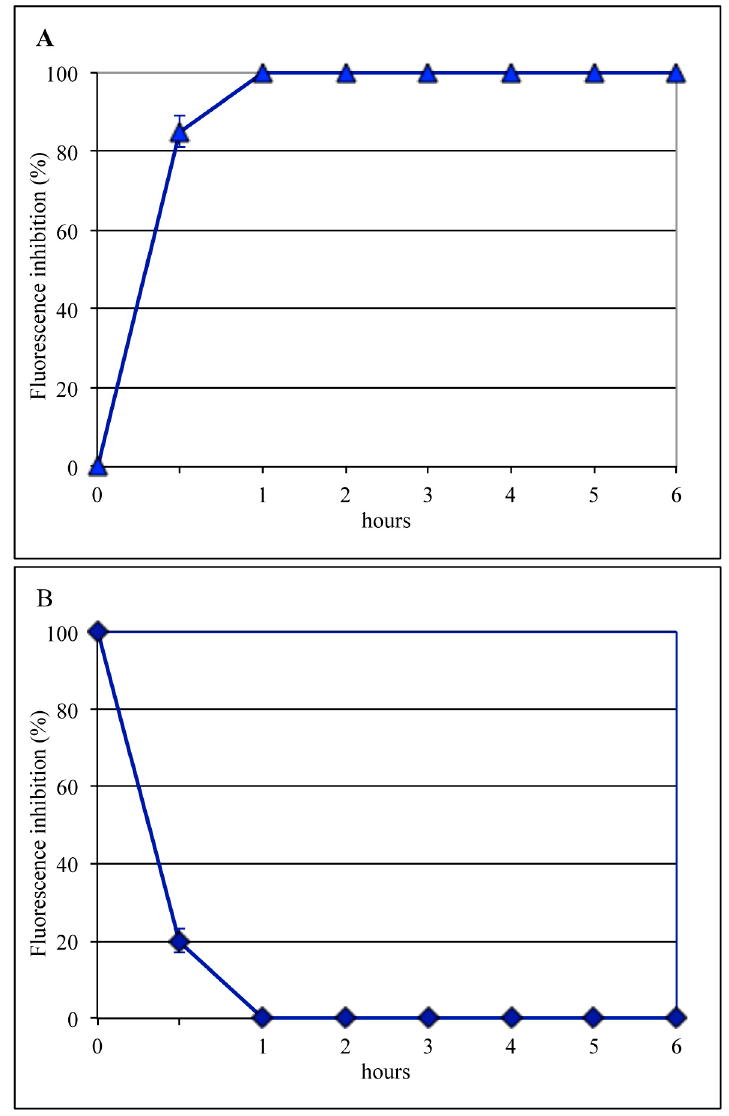
Figure 3. Addition-time effect of 20 mM NH 4 Cl on influenza virus infection. ( A ) NH 4 Cl was added